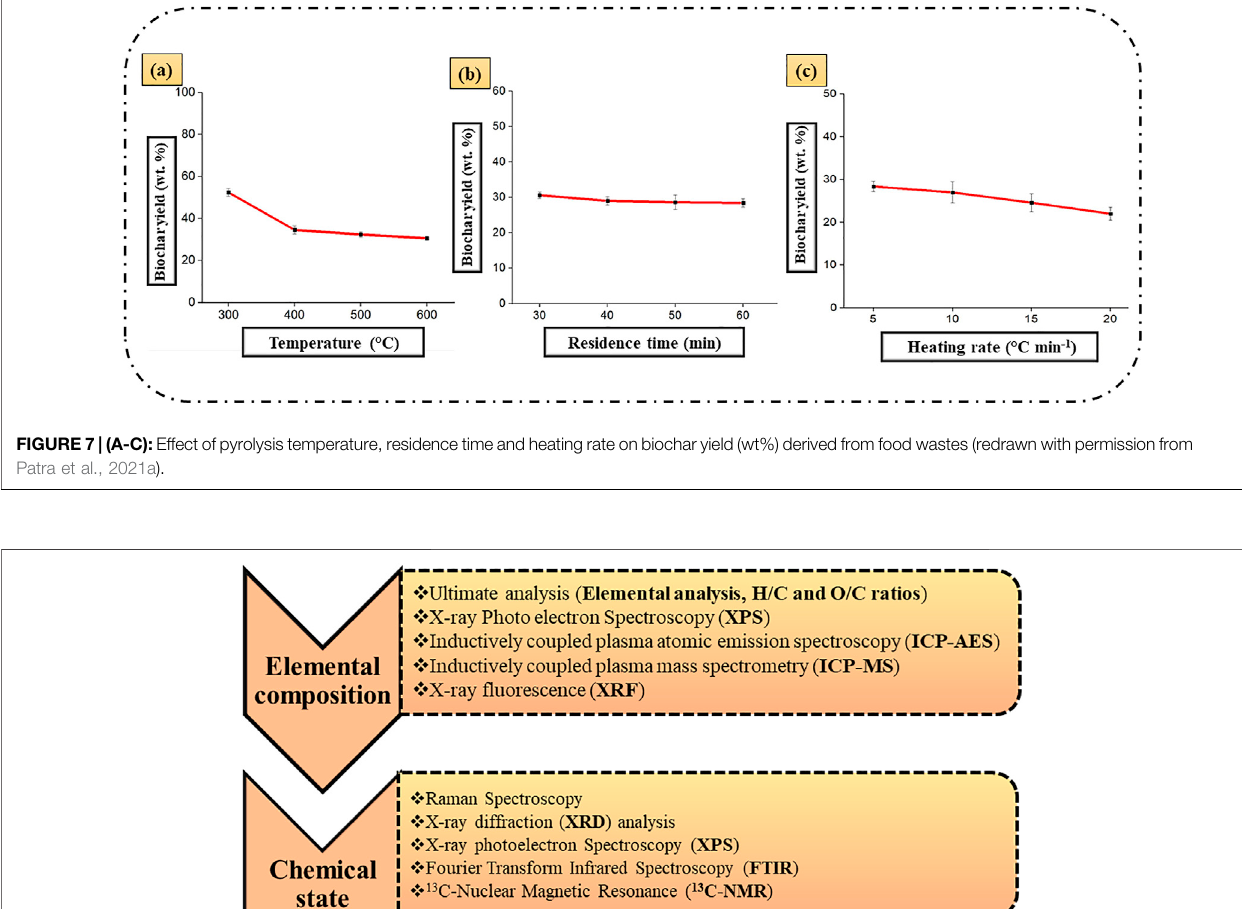
Frontiers in Materials |